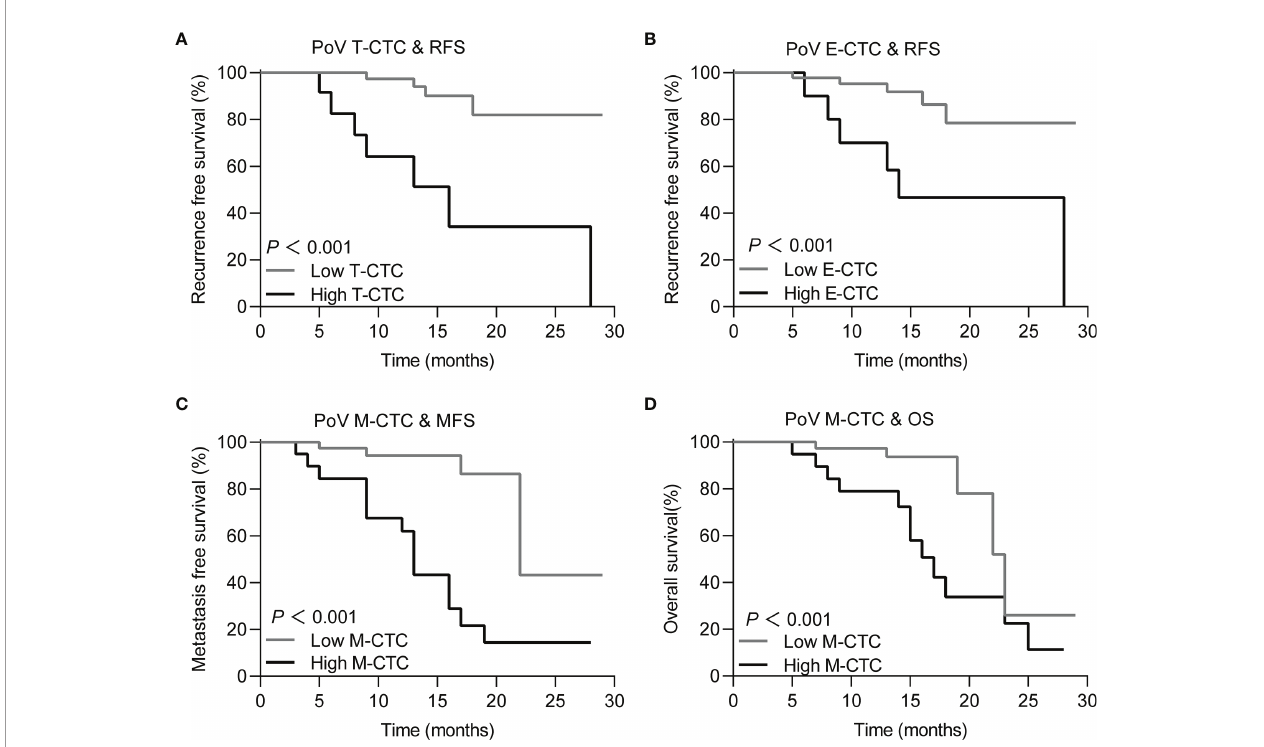
FIGURE 5 | Kaplan-Meier curves for PDAC patients with different prognosis in high/low CTC subtype count group for (A) T-CTC, for patients with high T-CTCs ( ≥ 14/5 ml) vs low T-CTC (<14/5 ml) and the mean RFS was 26.44 months (95%CI 24.07-28.83) vs 16.51 (95%CI 10.17 - 22.85). (B) E-CTC, for patients with high E-CTCs ( ≥ 5/ 5 ml) vs low E-CTC (<5/5 ml) and the mean RFS was 25.84 month (95%CI 23.268- 28.416) vs 18.51 (95%CI 12.106 - 24.927). (C) M-CTC, for patients with high M- CTCs ( ≥ 1/5 ml) vs low M-CTC (<1/5 ml) and the mean MFS was 14.19 month (95%CI 10.77 - 17.61) vs 23.78 (95%CI 19.207 - 28.368). (D) M-CTC, for patients with high M-CTCs ( ≥ 1/5 ml) vs low M-CTC (<1/5 ml) and the mean OS was 17.28 months (95% CI 13.91 to 20.65) vs 22.87 months (95% CI 19.51 -